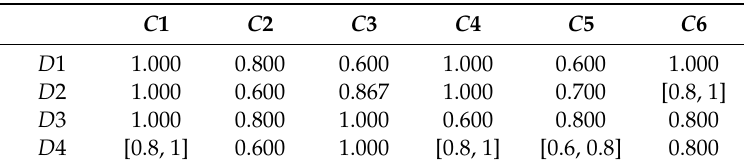
Table 3. Complete information of criterion weights.